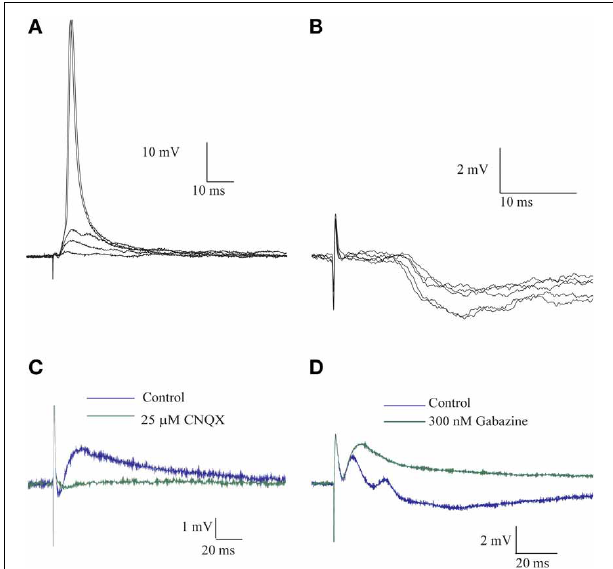
FIGURE 1 | The afferent input to AENs evokes a mixture of excitatory and inhibitory synaptic responses. All traces are Intracellular recording from an AEN. (A) The excitatory response of AEN to stimuli delivered to the afferent nerve at gradual increase in stimulus intensity. (B) As in (A) for a case of Inhibitory responses. (C) Application of CNQX completely blocked the response to afferent nerve stimulation. (D) In a different preparation, application of gabazine blocked the inhibitory response and revealed the underlying excitatory response.